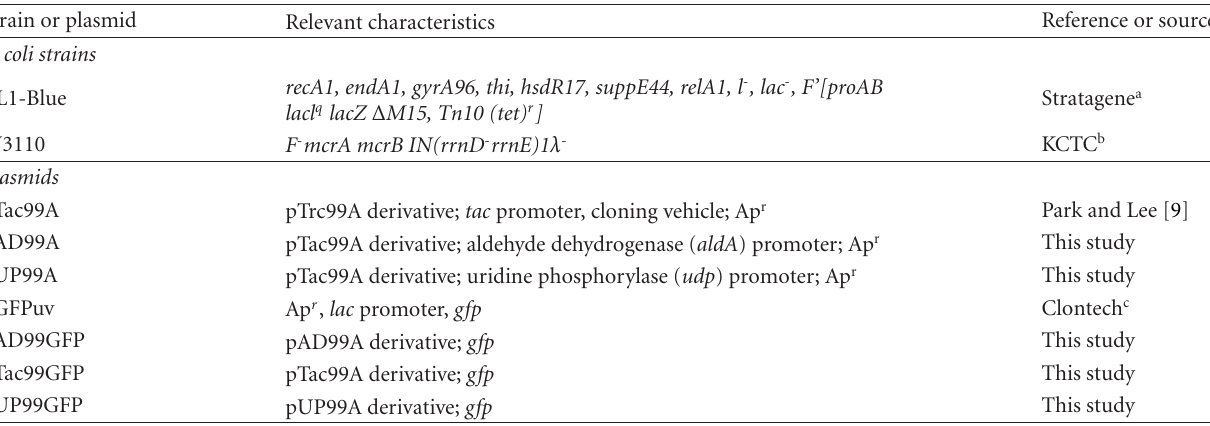
Table 1: Bacterial strains and plasmids used in this study.